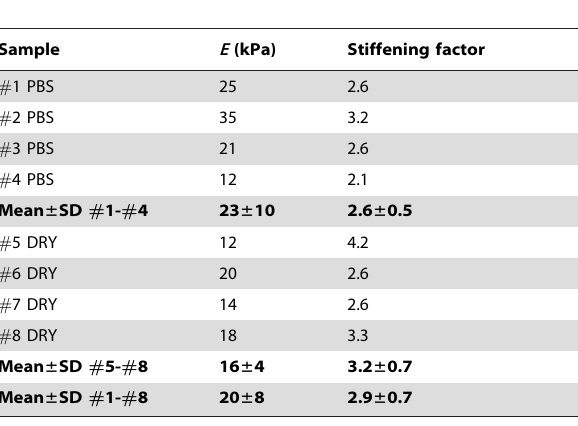
Table 6. Young’s moduli E (kPa) and stiffening factors across the cross-linked (CXL)